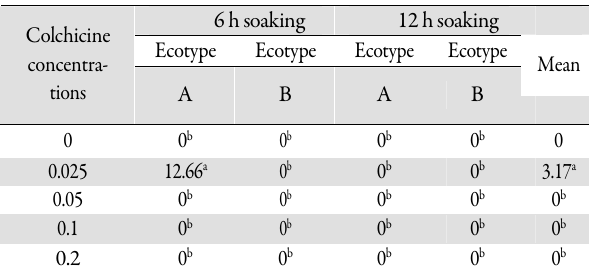
Tab. 2. The effect of colchicine concentration and soaking time on tetraploidy induction (%) of two Iranian mint ecotypes ( Mentha mozaffarianii Jamzad.)